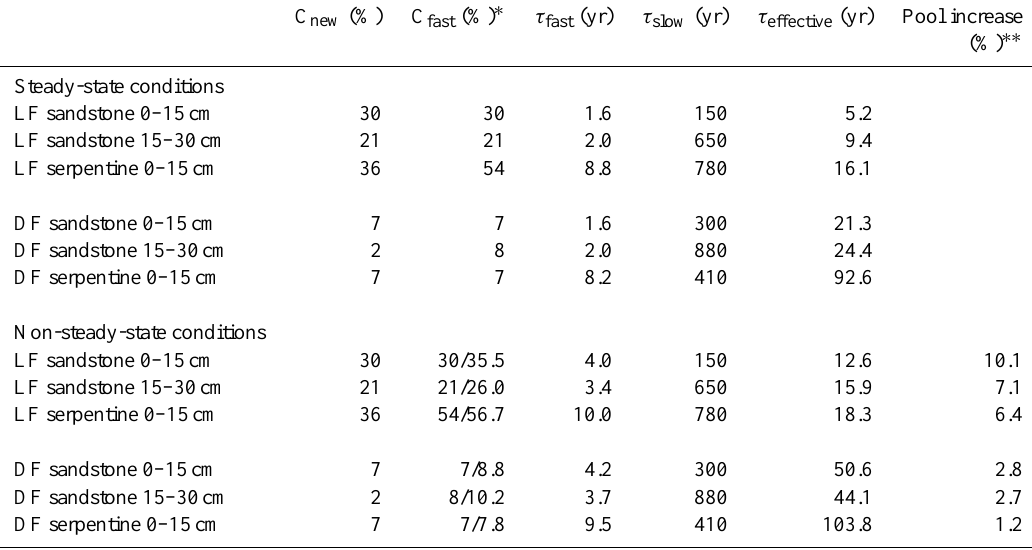
∗ Under non-steady-state conditions, C fast (%) increased from pre-experiment years (before 1992) to 1997 due to the faster incorporation of increased plant inputs to the fast-cycling component. ∗∗ Percent increase in soil carbon pool from pre-experiment years (before 1992) to 1997 due to increased plant inputs in the elevated CO 2